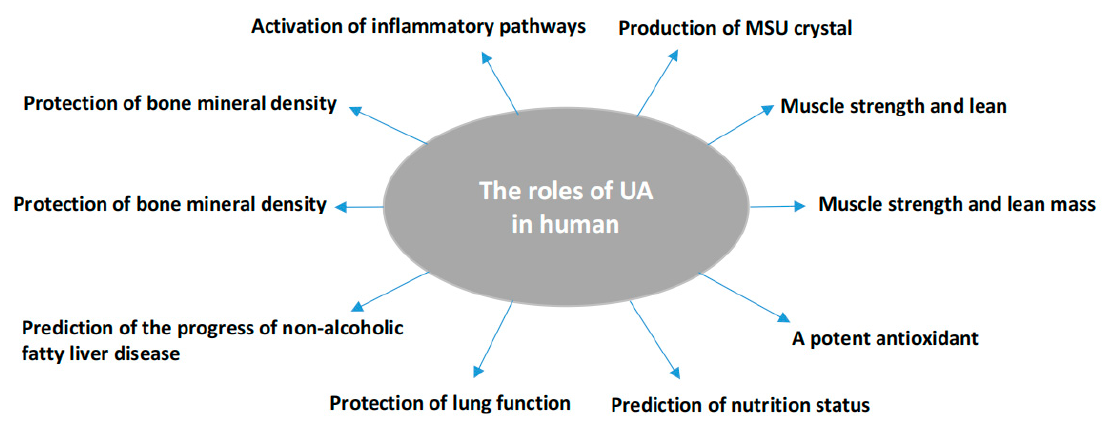
Figure 1. Summary of the pathophysiologic roles of uric acid in humans as identified in the review. Beyond its role in protection, over-saturated SUA together with sodium could deposit in joints, soft tissues, bones, skin, etc., as MSU crystals to form tophi and trigger